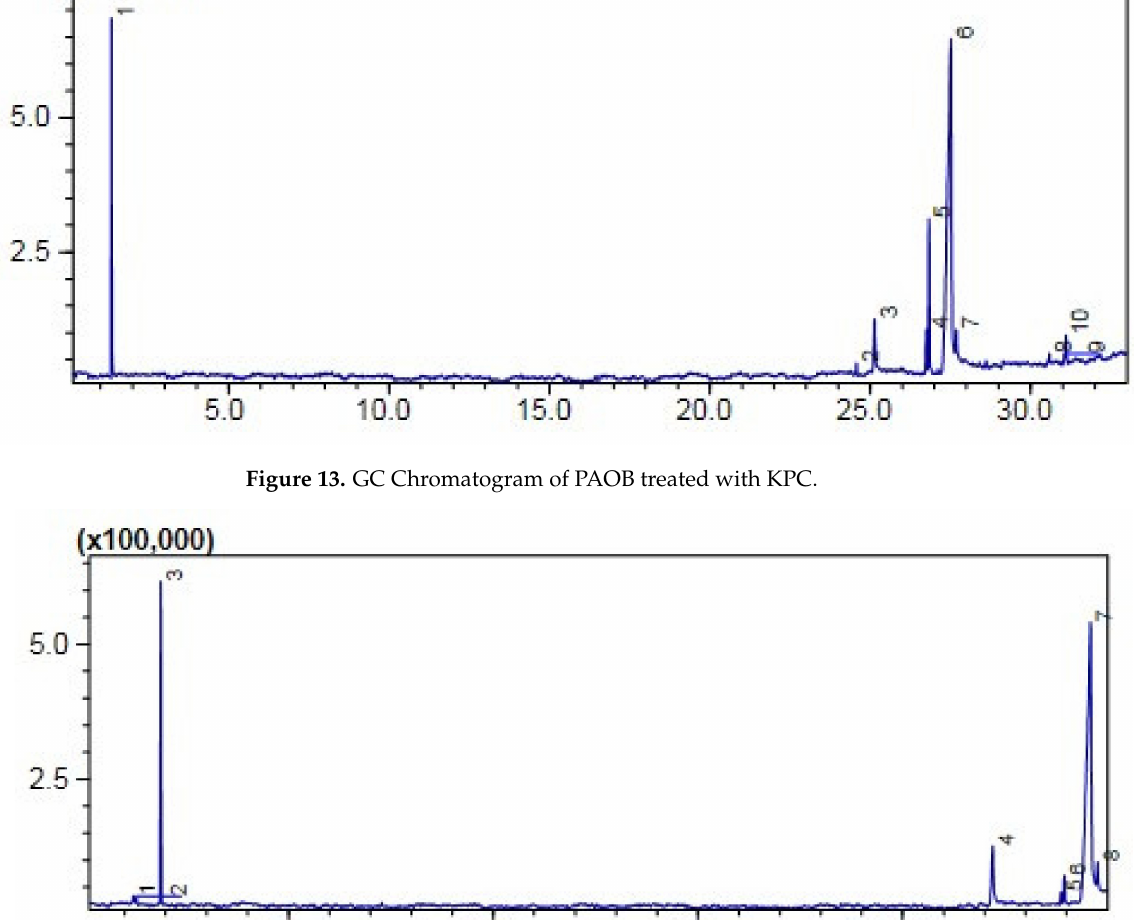
Figure 14. GC Chromatogram PAOB treated with